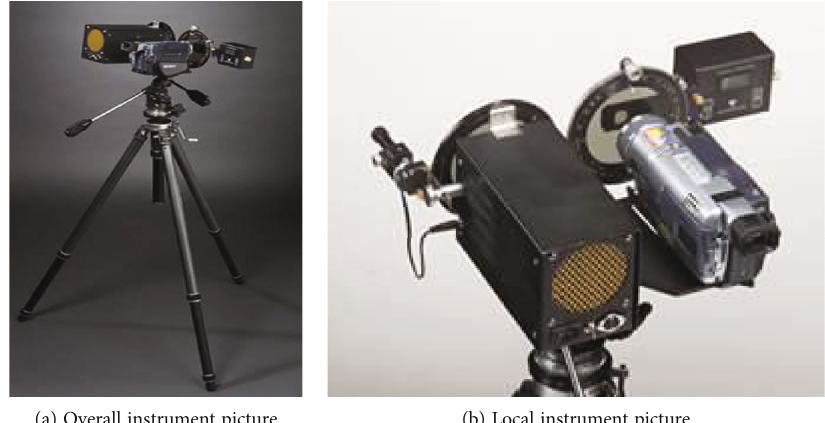
Figure 2: Composition of re fl ective photoelastic